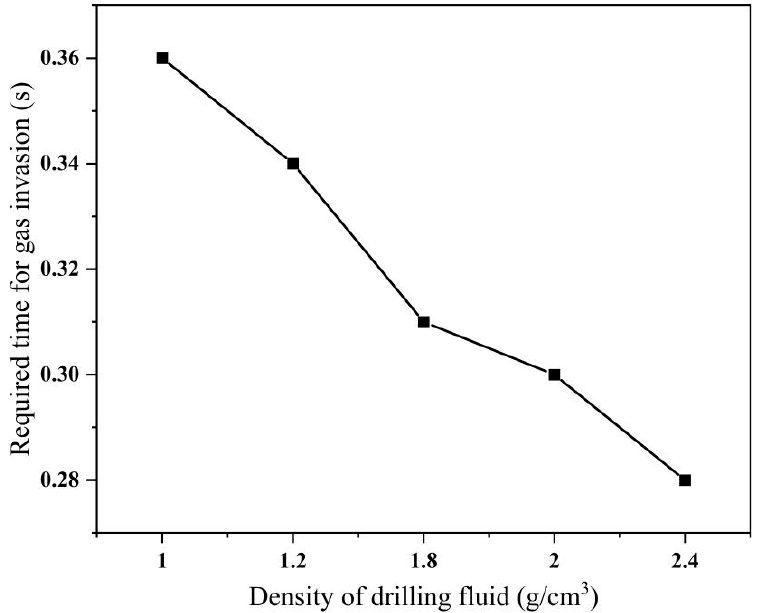
Figure 9. Time required for gas invasion under different drilling fluid densities.